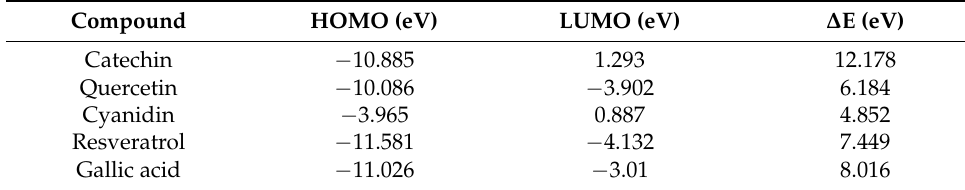
Table 2. Bandgap in eV of the proposed phytochemical markers in wine.